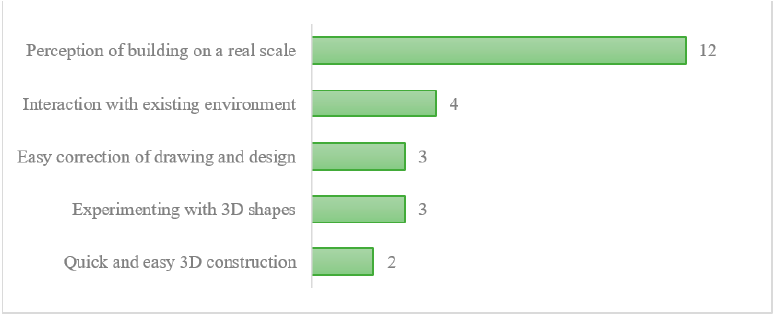
Figure 7. The most highly rated advantages of using IVR in design, according to students.